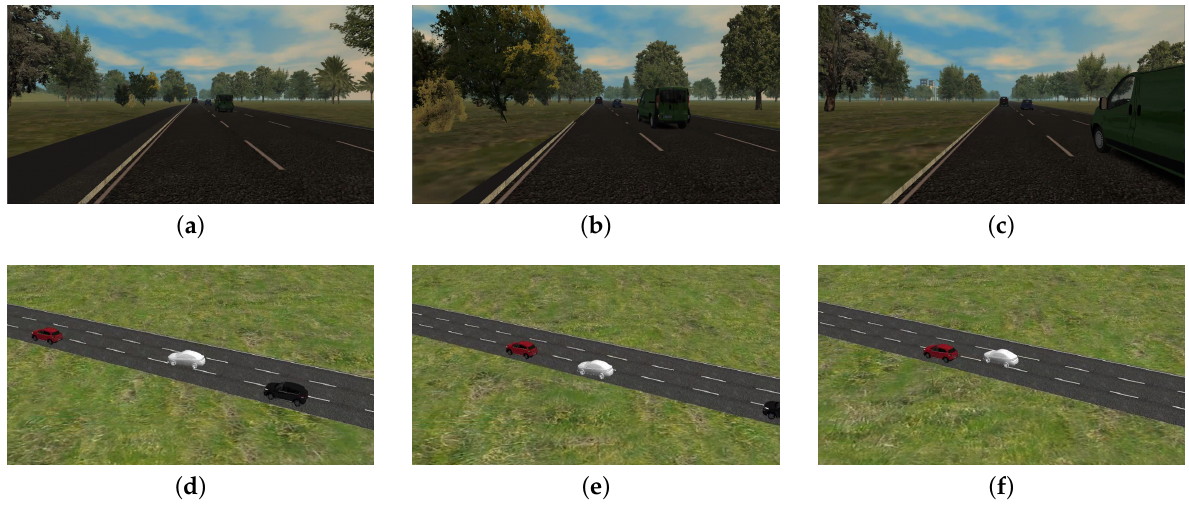
Figure 9. Three image frames extracted from two simulator video-outcomes. ( a – c ) show the simulator inner (or driver) view, when the automatic pilot is driving on a highway with medium traffic conditions. ( d – f ) illustrate the simulator top (or virtual) view, when the vehicle is executing a double overtaking